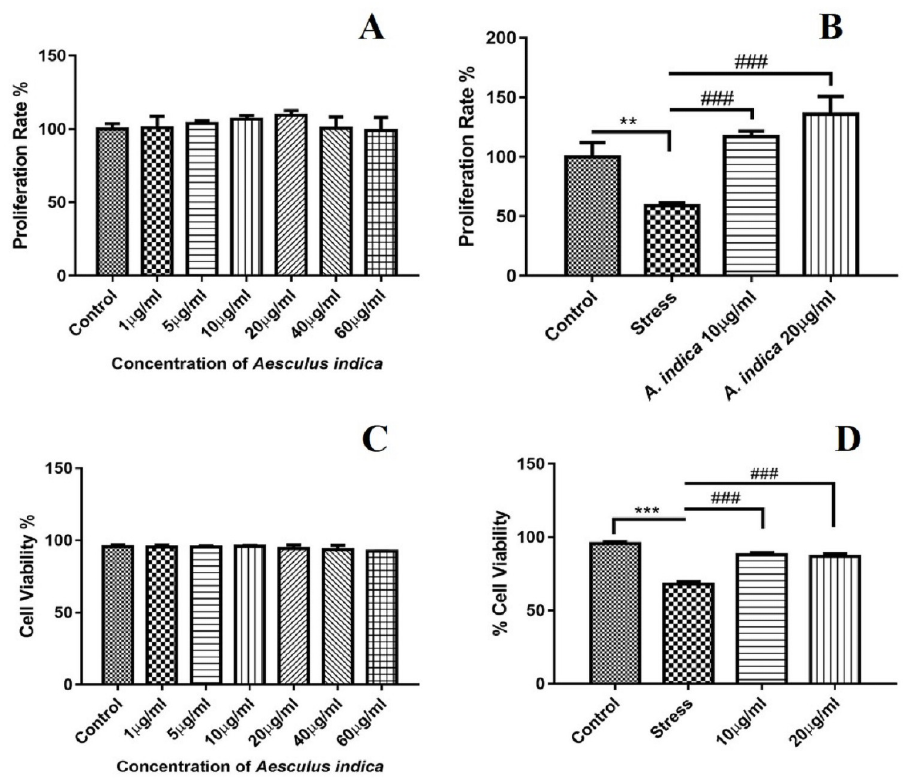
Fig 1. Bar graphs representing the metabolic activity and viability of hADMSCs in response to MIA stress and A . indica preconditioning. A. Metabolic activity of hADMSCs preconditioned with different doses of A . indica extract. B. Metabolic activity of MIA induced hADMSCs against different A . indica concentrations. C. Viability of hADMSCs preconditioned with A . indica extract concentrations. D. Percent viability of MIA induced hADMSC’s after A . indica preconditioning. Values are statistically significant at p � < 0.05, p �� < 0.01, p ��� < 0.001compared with the control group while p# < 0.05, p## < 0.01, p### < 0.001 compared with stress group. The experiment was carried out in triplicates (n = 3).